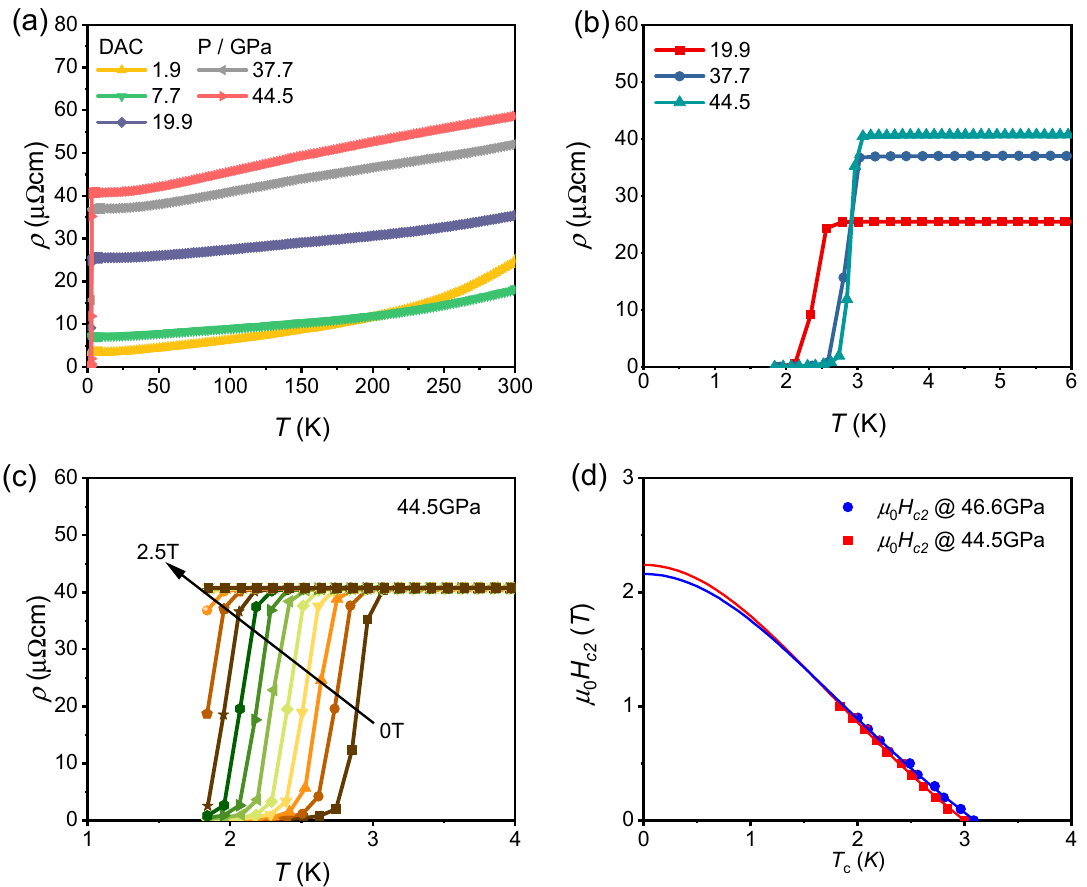
Figure 3. ( a ) Electrical resistivity of PdTeI as a function of temperature under high pressures up to 44.5 GPa. ( b ) Temperature-dependent resistivity of PdTeI in the vicinity of the superconducting transition. ( c ) Temperature dependence of resistivity under different magnetic fields for PdTeI at 44.5 GPa. ( d ) The upper critical field µ 0 H c2 ( T ) as a function of temperature at representative pressures. The solid lines correspond to the results of fitting by Ginzburg–Landau (G-L) formula. In situ HP synchrotron XRD measurements were carried out on powered single crystals of PdTeI to clarify whether the pressure-induced SC is associated with structural phase transition (Figure 4a). In the low-pressure range, most diffraction peaks of PdTeI could be indexed to the tetragonal P 4 2 /mmc structure. When increasing the pressure, all peaks slowly shift to higher angles and no structural phase transition is observed up to 13.3 GPa. As shown in Figure 4b, both a - and c -axial lattice parameters decrease with increasing pressure. Interestingly, above 18.22 GPa, apart from the formation of a broad diffusive peak at ≈ 13 ◦ , the Bragg peaks disappear from the XRD spectra. It demonstrates that PdTeI may go through an amorphous phase transition persistent up to 75.6 GPa. In addition, upon decompression, the amorphous behavior is maintained. Meanwhile, in situ HP Raman spectroscopy experiments were also carried out up to 31 GPa (Figure 4c). At 1.0 GPa, PdTeI displays seven Raman vibrational modes at 34.8, 44.4, 70.4, 81.5, 127.2, 140.8 and 147.4 cm − 1 , respectively. The split of Raman peak around 127 cm − 1 and the red shift around 141 cm − 1 (Figure 4d) above about 1.3 GPa may related with the suppression of CDW. Consistent with the pressure-induced amorphization from the XRD results aforementioned, all the Raman modes disappear above 15.4 GPa corresponding to completion of the structural